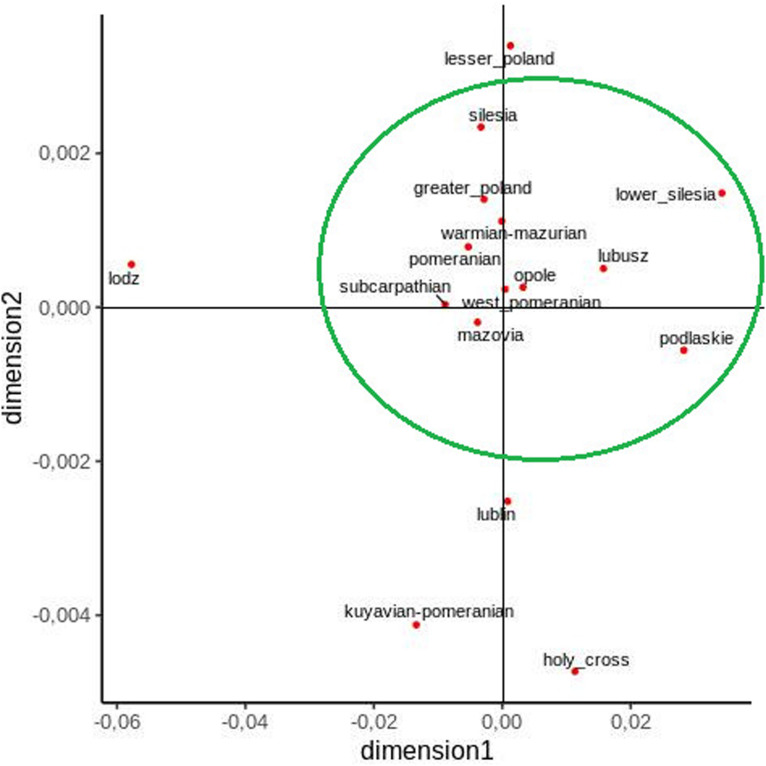
Two-dimensional MDS plot of Polish voivodeship populations based on pairwise FST values.